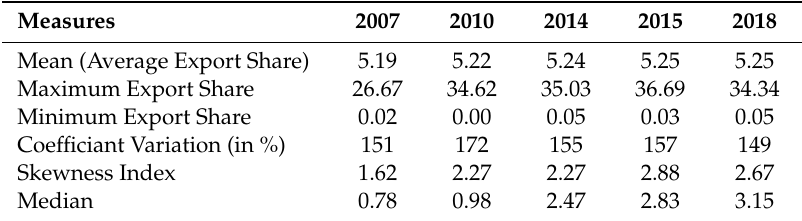
Table 2. Descriptive statistics for share of country’s total exports of photovoltaic panels of the 19 top exporters countries, in 2007–2018.